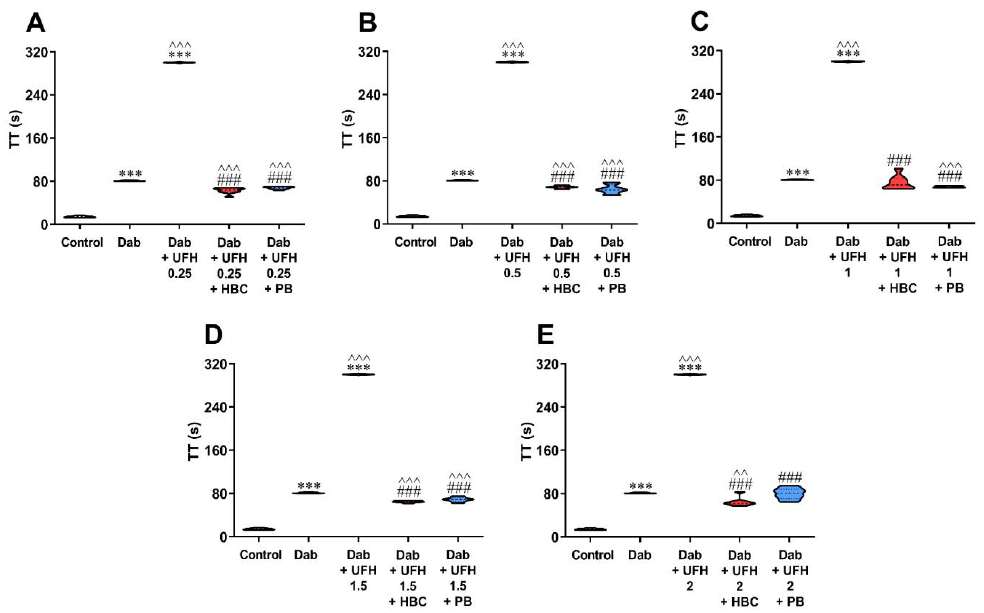
Figure 2. Inhibition of UFH at a concentration of 0.25 ( A ), 0.5 ( B ), 1 ( C ), 1.5 ( D ), and 2 U/mL ( E ) by HBC or polybrene at a concentration of 50 µg/mL during testing of dabigatran (50 ng/mL) anticoag- ulant activity by TT in human plasma. *** p < 0.001 vs. control; ^^ p < 0.01, ^^^ p < 0.001 vs. dabigatran; ### p < 0.001 vs. dabigatran with UFH, Mann–Whitney test. The results are shown as violin plots with minimum and maximum values and analyzed with GraphPad Prism 8 software. Dab, dabigatran; HBC, heparin-binding copolymer; PB, polybrene; TT, thrombin time; UFH; unfractionated heparin.